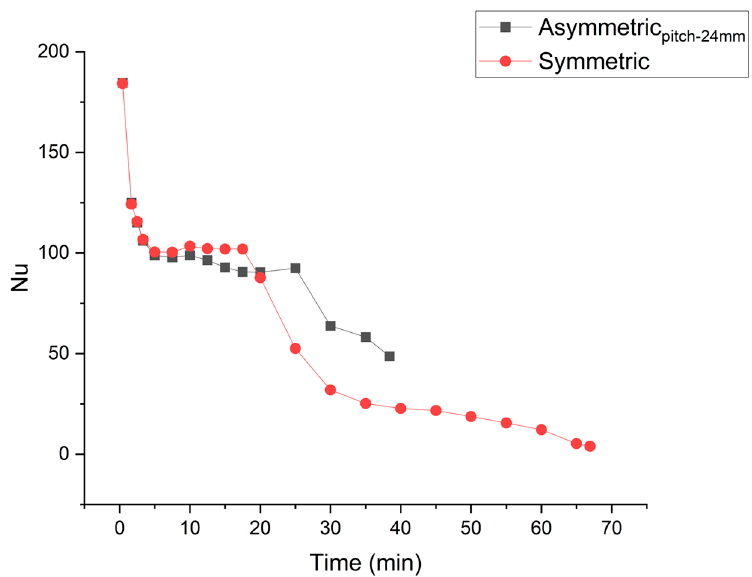
Figure 12. Nusselt number for two fin symmetric and asymmetric configurations (pitch-24 mm). The velocity vectors plotted in Figure 13 depict the evolution of buoyancy-driven